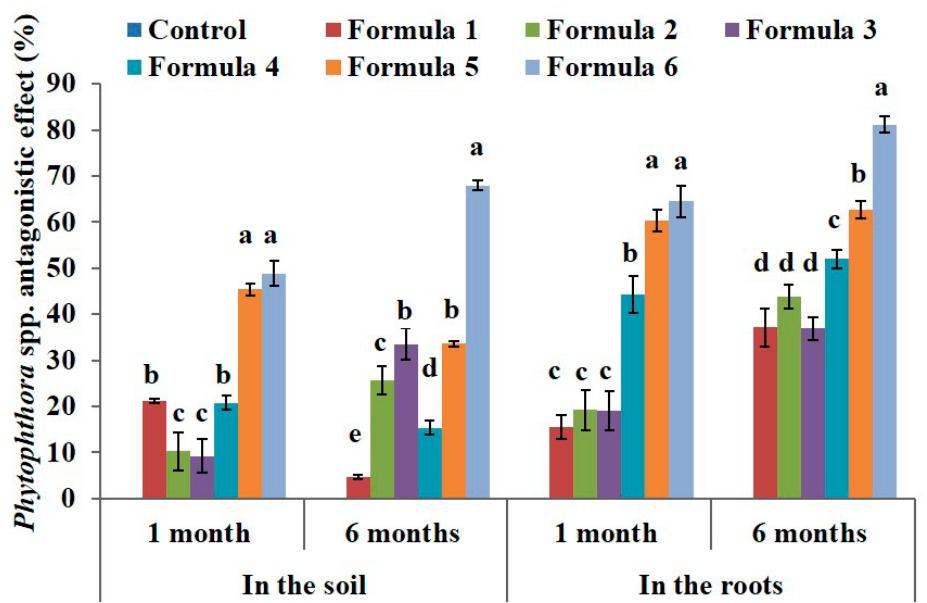
Figure 2. The effect of bio-products on Phytophthora spp. in the soil and in the roots at the black pepper farm after 1 month and 6 months of treatment. The experiment was designed 7 formulas involve control formula and six treated formulas as mentioned in Table 2. Data represent mean and error bars from three different replicates; each replicate contained at least 30 individual black pepper stumps per treatment. All statistical analyses including one-way variance analysis (ANOVA) and Duncan’s multi range test were carried out using Statistical Analysis Software (SAS 9.4). Different letters indicate statistically significant differences among the values of formulas analyzed after 1 month or 6 months ( p < 0.05). By using the Henderson–Tilton formula to calculate the antagonistic effect, mean of control formula is always zero value.